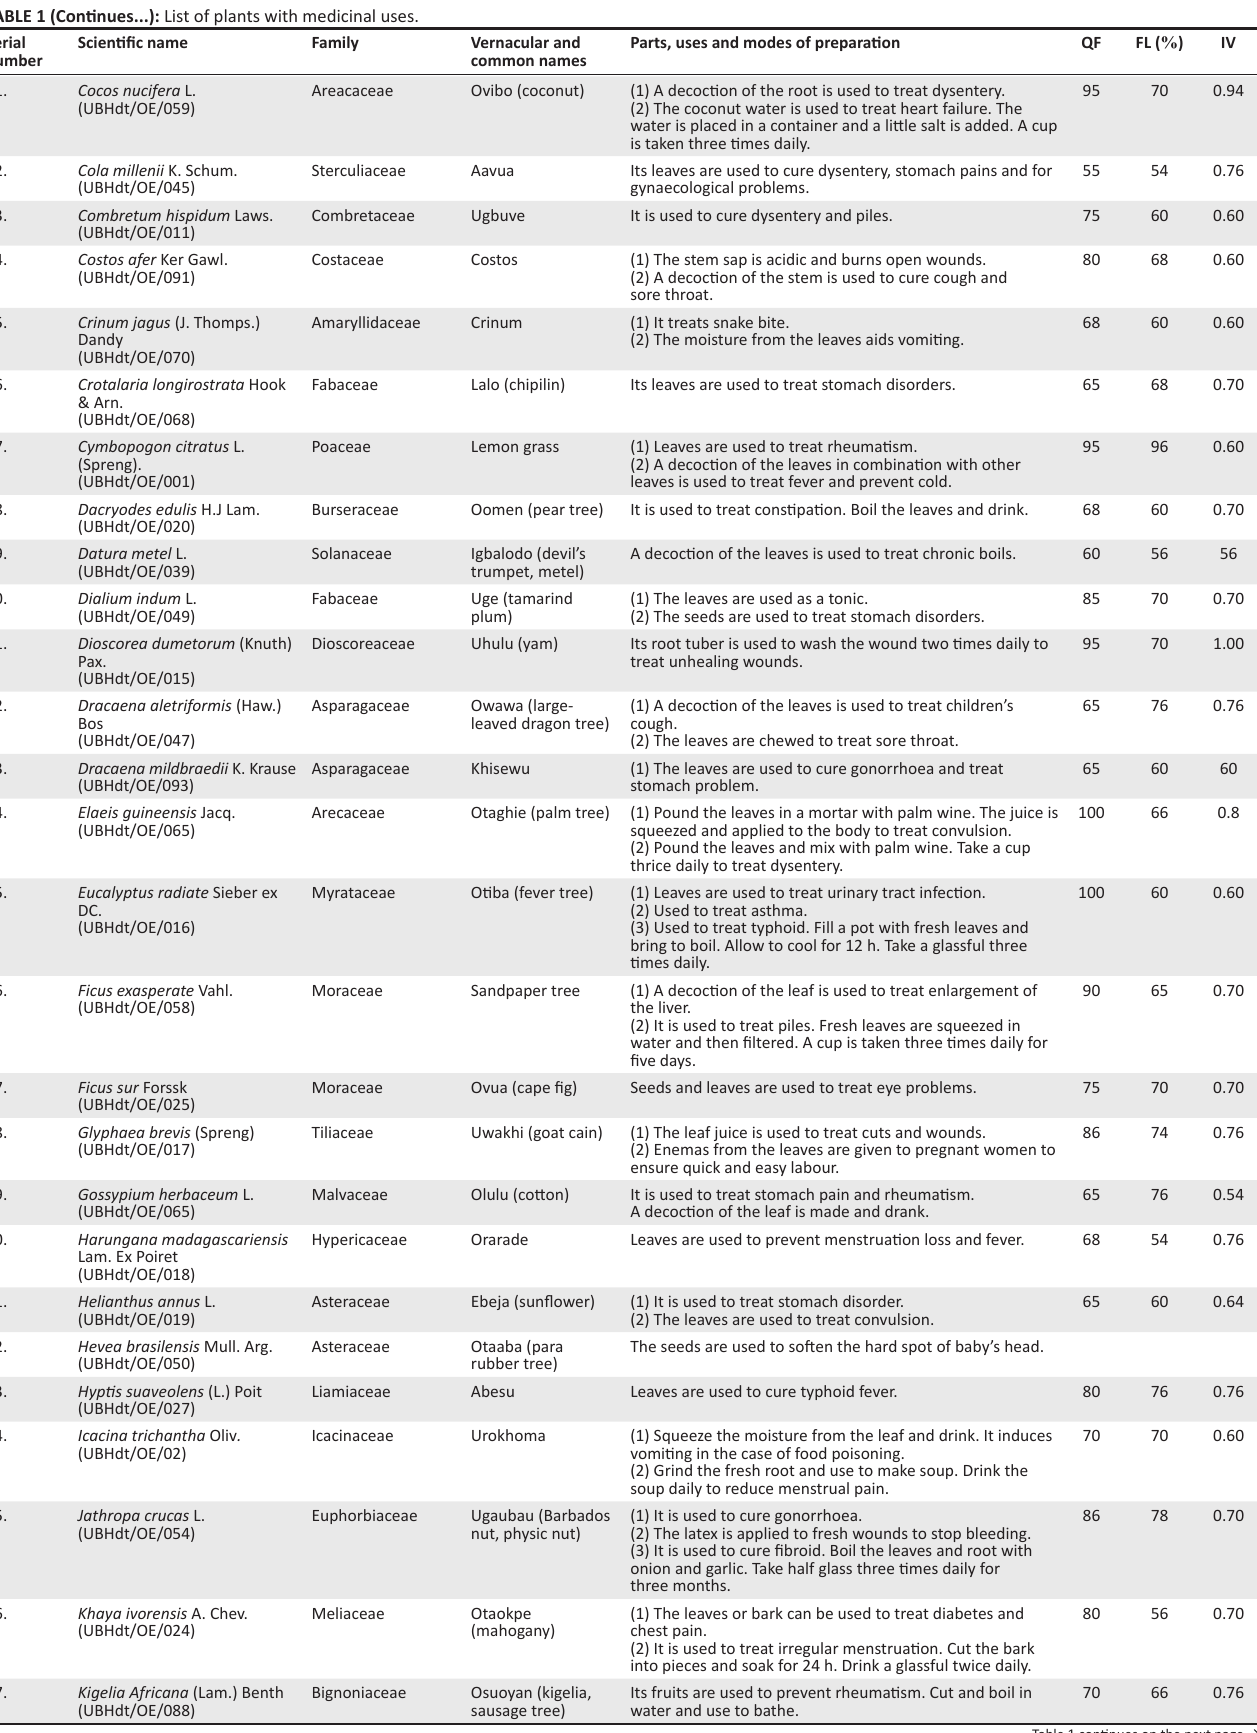
TABLE 1 (Continues...): List of plants with medicinal